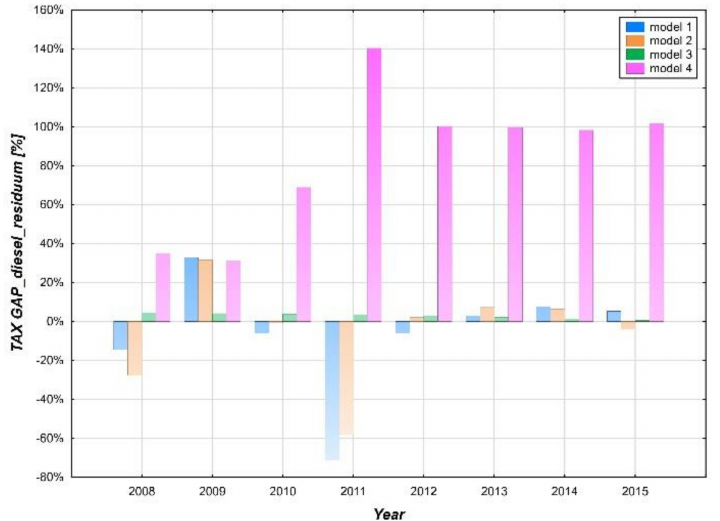
Figure 13. Residues of prediction models TAX GAP diesel (%) in the years 2008–2015.